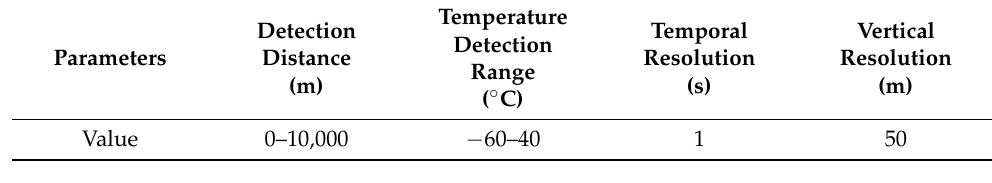
Table 2. The main technical parameters of the microwave radiometer.